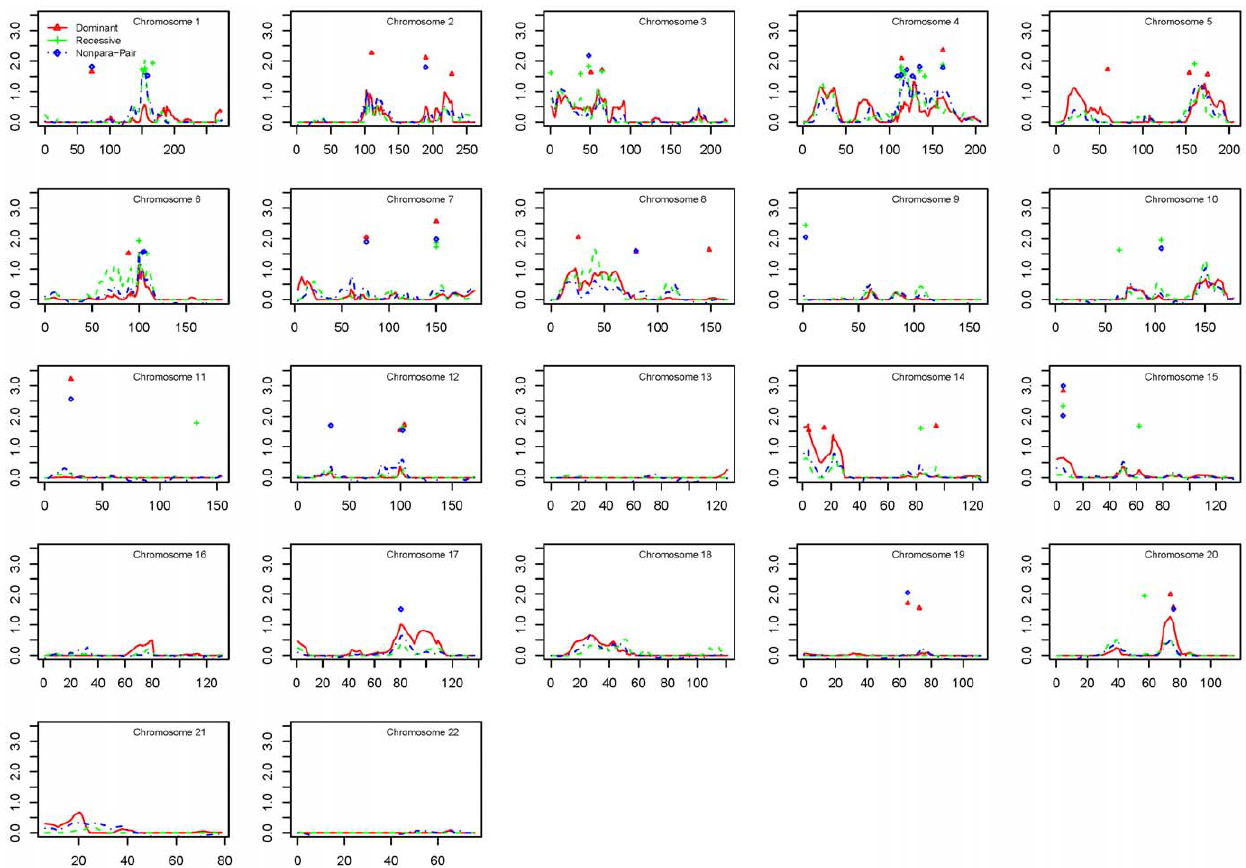
Figure 2. Linkage results for the Caucasian ancestry dataset. Multipoint linkage scores for parametric dominant (red), parametric recessive (green), and nonparametric (blue) models are plotted for the Caucasian ancestry dataset. Symbols indicate two-point lod scores $ 1.5 in the parametric dominant (red) and recessive (green) models.